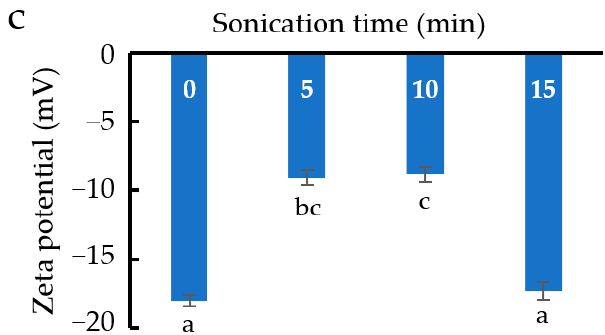
Figure 2. ( a ) Vesicle size, ( b ) size distribution, and ( c ) zeta potential of blank ethosomes treated by different sonication times. Different letters above the error bars indicate significant differences at the 0.05 level (ANOVA and post hoc test).